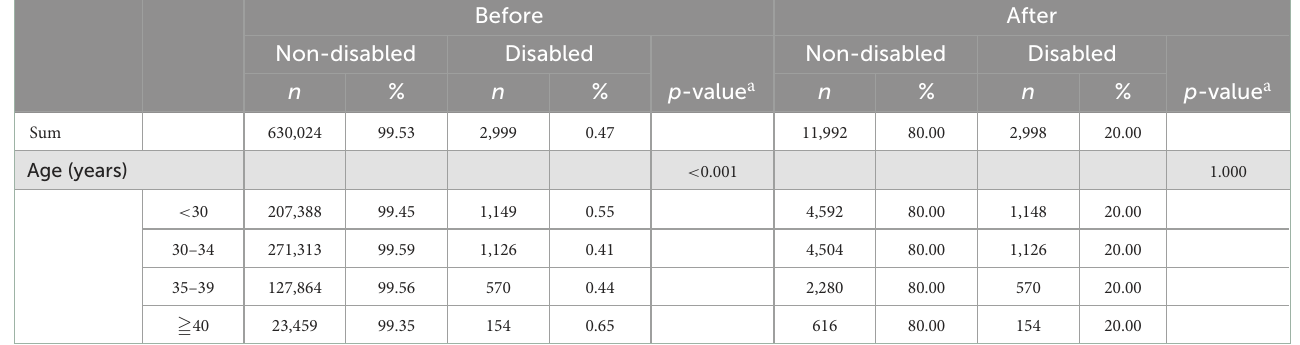
TABLE 1 Age distribution before and after pairing of disabled pregnant women and non-disabled pregnant women. Before After Non-disabled Disabled Non-disabled